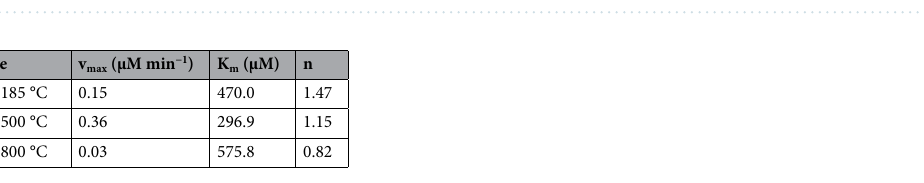
Table 1. Kinetic parameters with H 2 O 2 as substrate derived from the Michaelis–Menten equation.